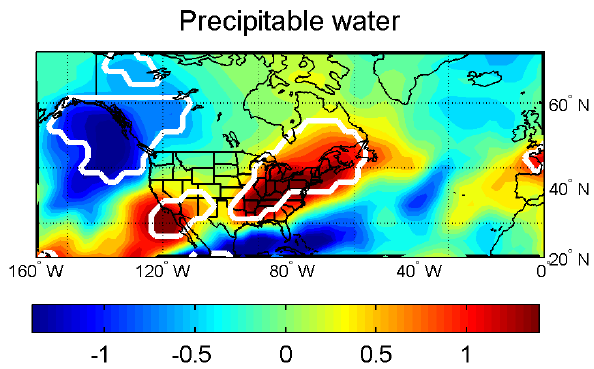
Figure 10. Composite differences between the 12 years with the greatest increase and 12 years with the greatest decrease of wintertime (NDJ) lake-level for high-pass filtered seasonal anomalies of precipitable water (kg/m 2 ). Areas encompassed by white lines indicate significant differences at the p < 0.05